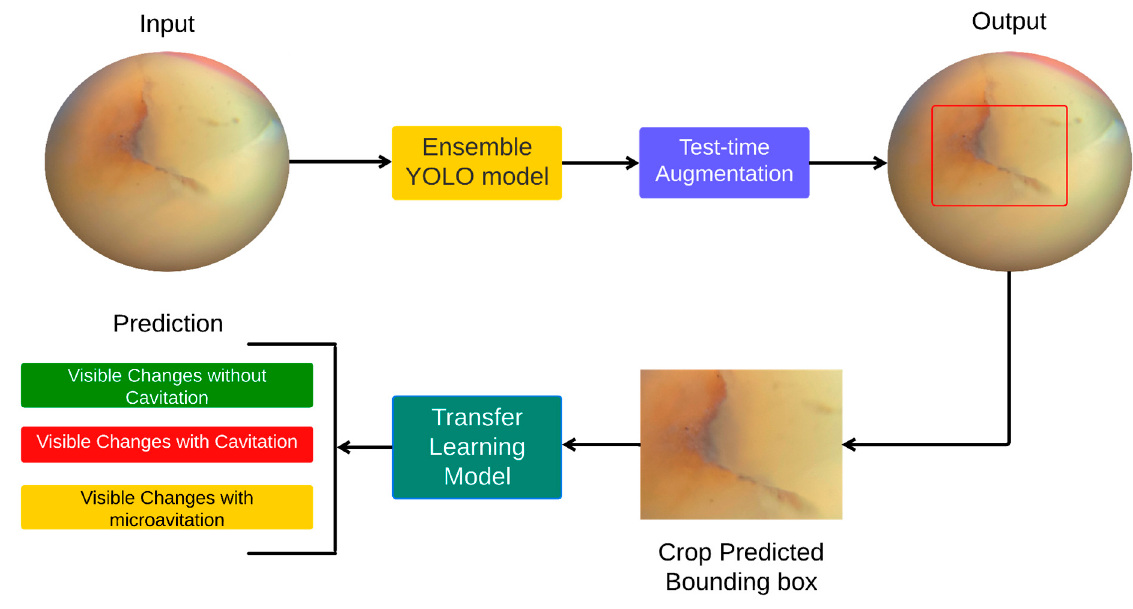
Figure 2. Flowchart summary of the proposed method.